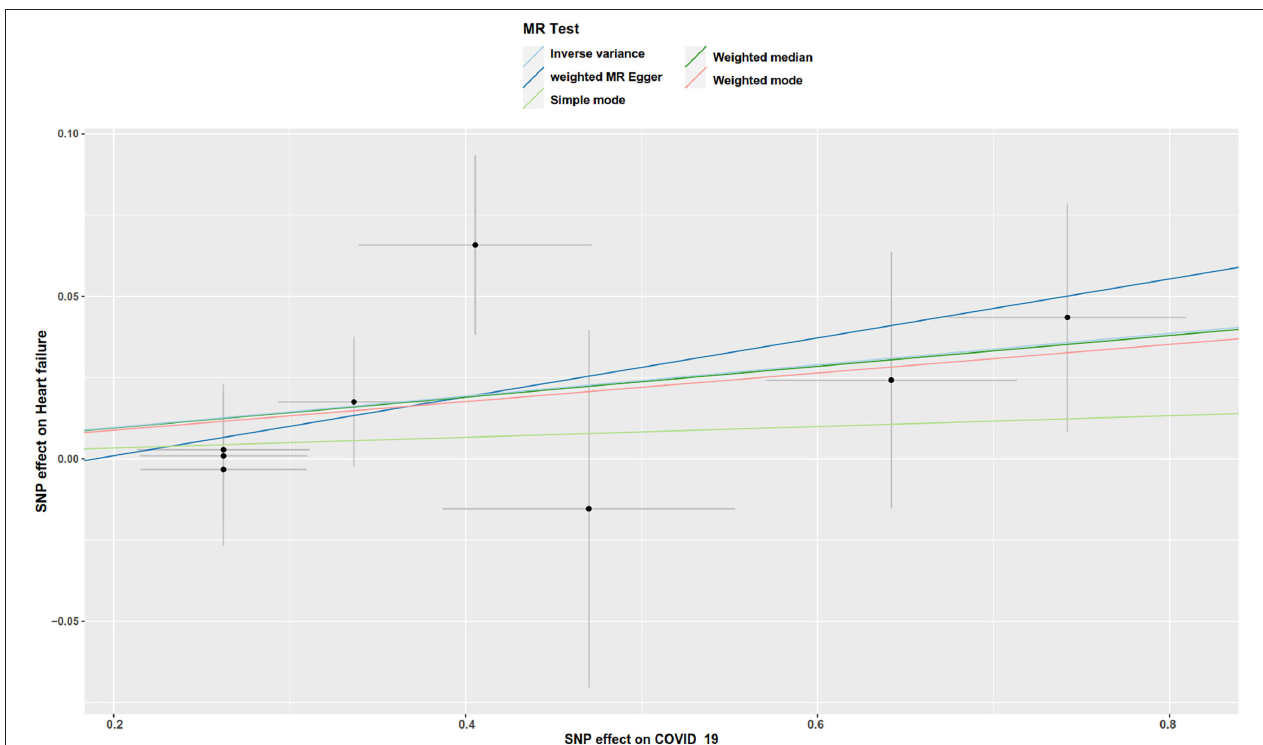
FIGURE 4 | Scatter plot to visualize the causal effect of COVID-19 on the risk of heart failure. The slope of the straight line indicates the magnitude of the causal